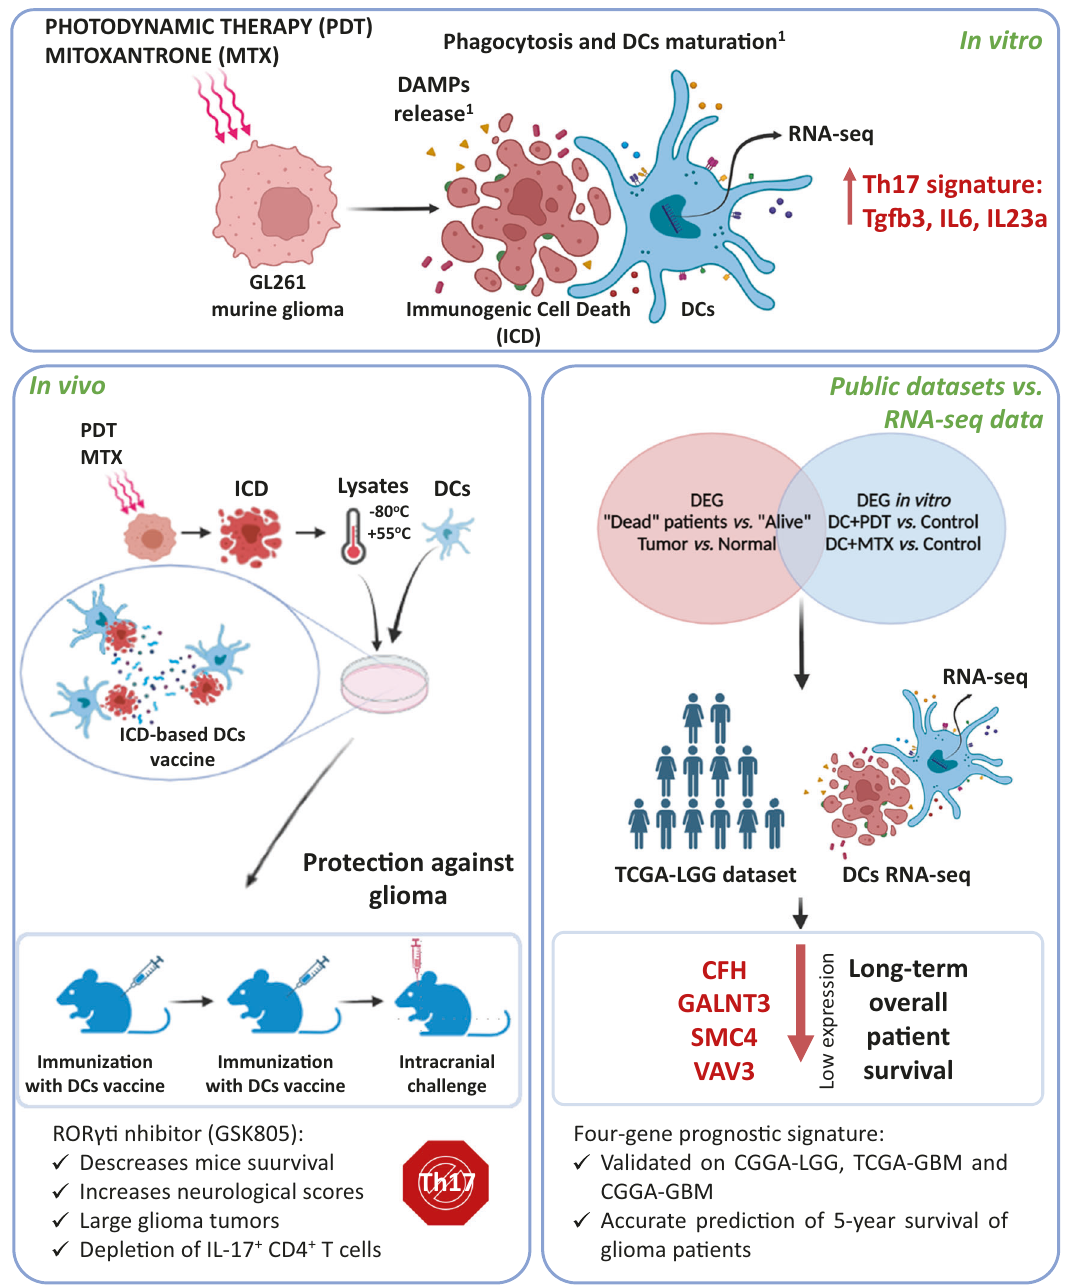
Fig. 8 DC vaccines loaded with glioma cells killed by PS-PDT induce Th17 anti-tumor immunity and provide a four-gene signature for glioma prognosis (graphical abstract). We developed ICD-based DC vaccines and demonstrated that they induce signi fi cant protective immunity against glioma in the orthotopic model. To investigate the molecular mechanism of DC vaccines loaded with glioma cells undergoing ICD, we performed a comparative analysis of their transcriptional levels in two ICD-inducing modalities (PS-PDT and MTX) and we analyzed the marker genes responsible for T cells differentiation (Th1, CTL, Th17, and Treg). This study revealed that the expression of DC genes the products of which (Tgfb3, Il6, and Il23a) activate Th17 cells were expressed at high levels in DCs cocultured with dying glioma cells treated with PS-PDT or MTX compared to control. Notably, blocking ROR γ t reduced the protection of DC vaccines loaded with dying glioma cells treated with PS-PDT in the orthotopic glioma model. Finally, by matching differentially expressed genes (DEG, between “ ALIVE ” and “ CONTROL ” patients in TCGA-LGG datasets) from our RNA-seq data of DCs cocultured with glioma GL261 cells treated with PS-PDT or MTX, we established a predictive model based on the four-gene signature (CFH, GALNT3, SMC4, and VAV3). Application of this signature to the TCGA- LGG dataset predicted the patients ’ overall survival. When it was validated on the overall survival of the CGGA-LGG, TCGA-GBM, and CGGA- GBM datasets, it accurately predicted the fi ve-year survival rates. In conclusion, in this study we have shown that DC vaccines loaded with glioma cells killed by photodynamic therapy induce Th17 anti-tumor immunity and provide a four-gene signature for glioma prognosis. These fi ndings open attractive prospects for improving glioma therapy by employing ICD and PS-PDT-based DC vaccines to induce Th17 immunity and to using the prognostic model to predict the overall survival of glioma patients. 1 Of note, in the previous study we demonstrated that dying/dead GL261 cells treated with PS-PDT undergo typical hallmarks of ICD such as exposure on their surface calreticulin and release DAMPs such as ATP and HMGB1 [20]. Importantly dying/dead GL261 treated with PS-PDT induce ef fi cient activation and maturation of DCs in vitro [20] justifying their use as a vaccine in the current